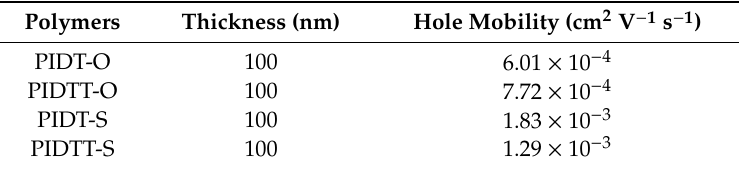
Table 3. Summary of the hole mobilities of the neat